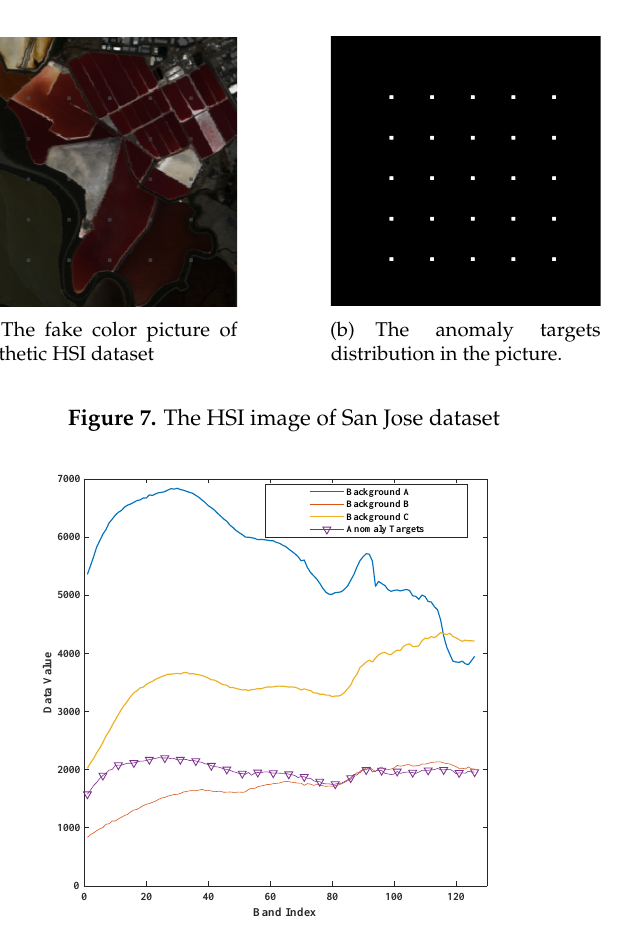
Figure 8. The spectral signature of anomaly targets and average background pixel of San Diego